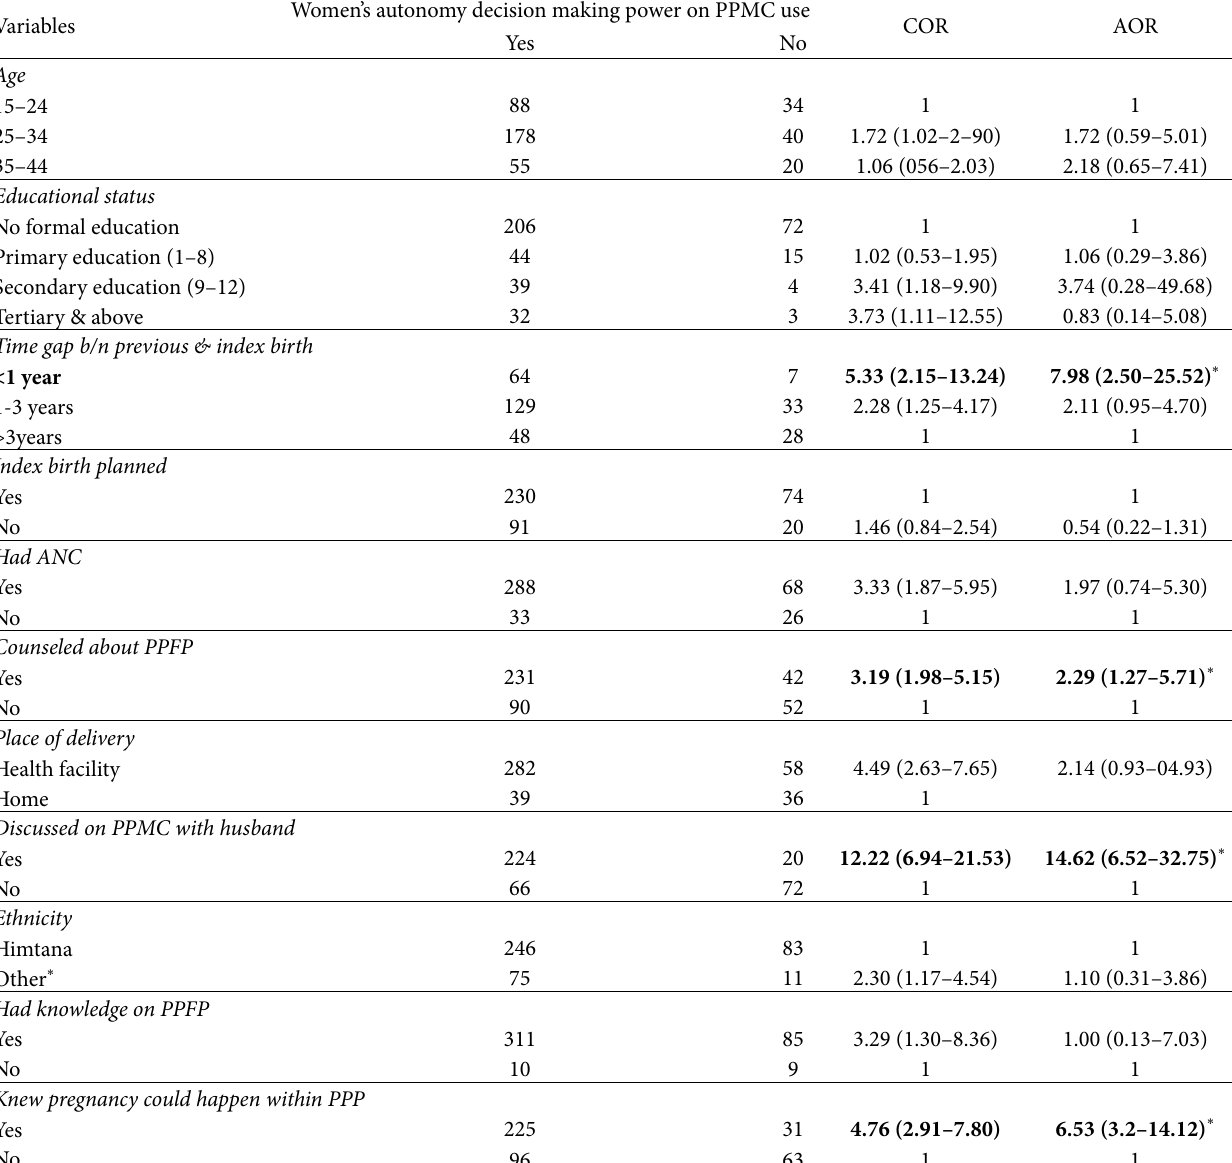
Table 5: Factors associated with women’s autonomy decision making power on PPMC use, in Sekota town and its surroundings, Northwest, Ethiopia 2017